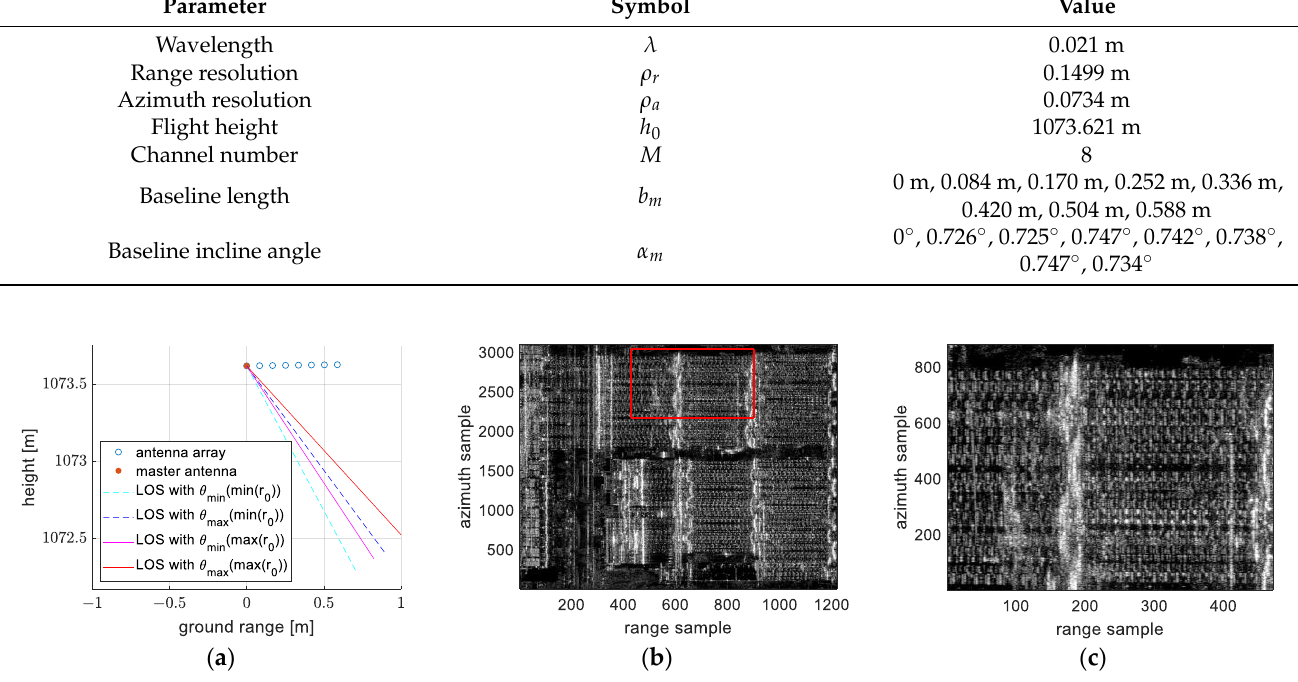
Figure 20. The selected region in experiment 1: ( a ) the configuration of the antenna array. The 2-D SAR image of the measured data: ( b ) the whole scene and ( c ) the inversion area in the red frame in ( b ).